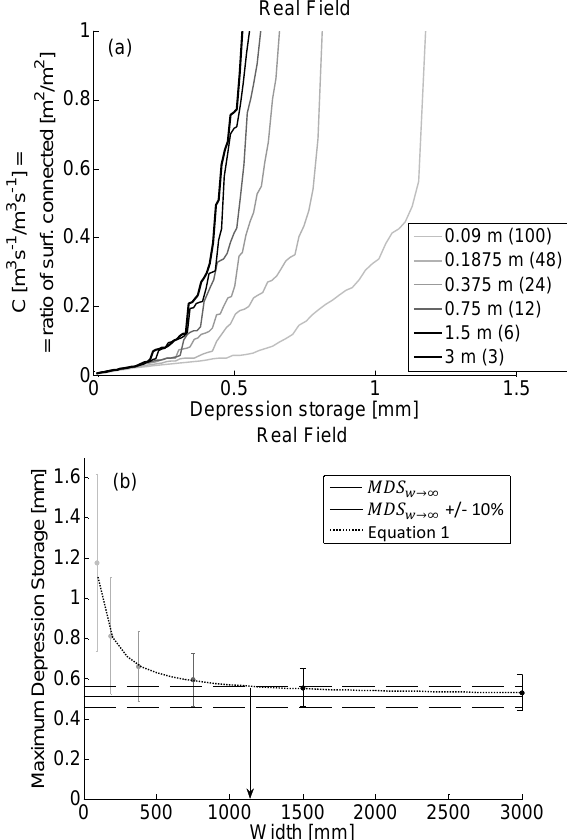
Figure 4: Real field – Effect of plot width on the average RSC function (a) and on the maximum depression storage (MDS) (b). The numbers in parentheses indicate the number of connectivity curves used for calculating the average RSC functions. Vertical bars = standard deviations. The arrow indicates the ‘representative width’. All the plots are 3 m long.